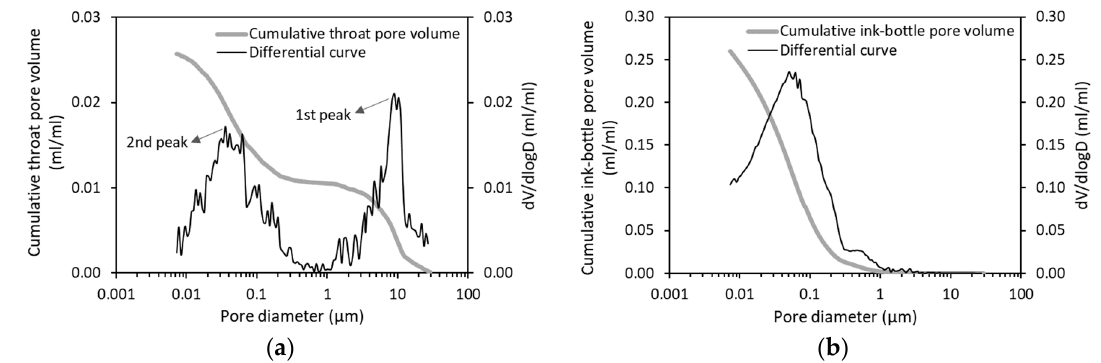
Figure 5. Distribution of ( a ) throat pores and ( b ) ink-bottle pores in OPC paste (w / b = 0.5, 28 days) determined by PDC-MIP measurements.